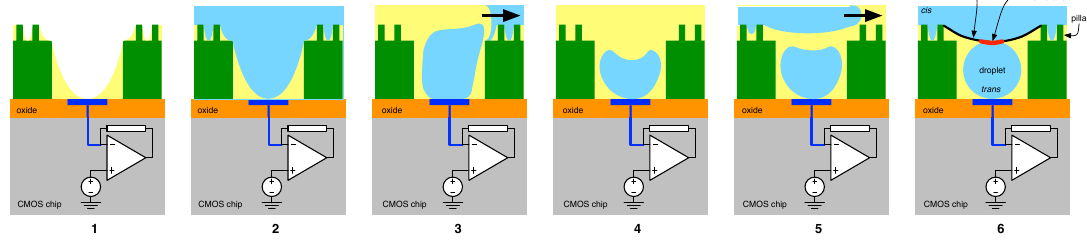
Figure 16. In situ formation of trans droplets in the micro-well array.